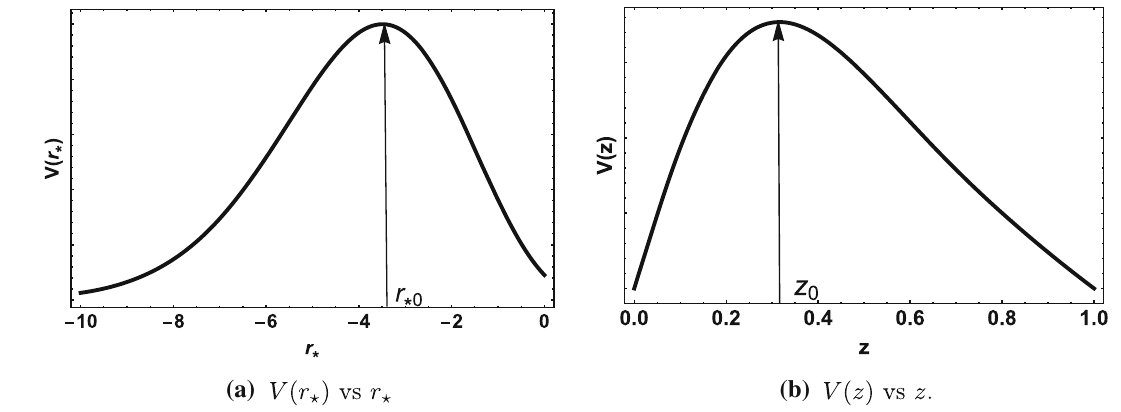
Fig. 21 a A rough picture V ( r (cid:23) ) in terms of a r (cid:23) coordinate, b a rough picture V ( z ) in terms of a z coordinate